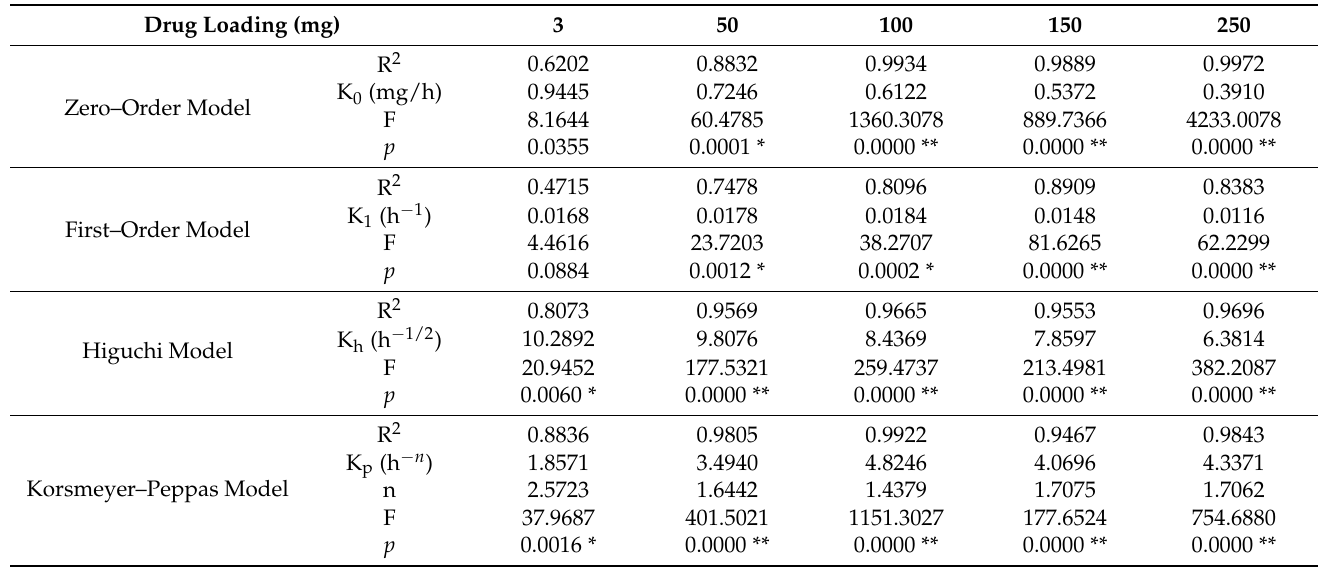
Table 2. Kinetic parameters of dissolution profile with different drug